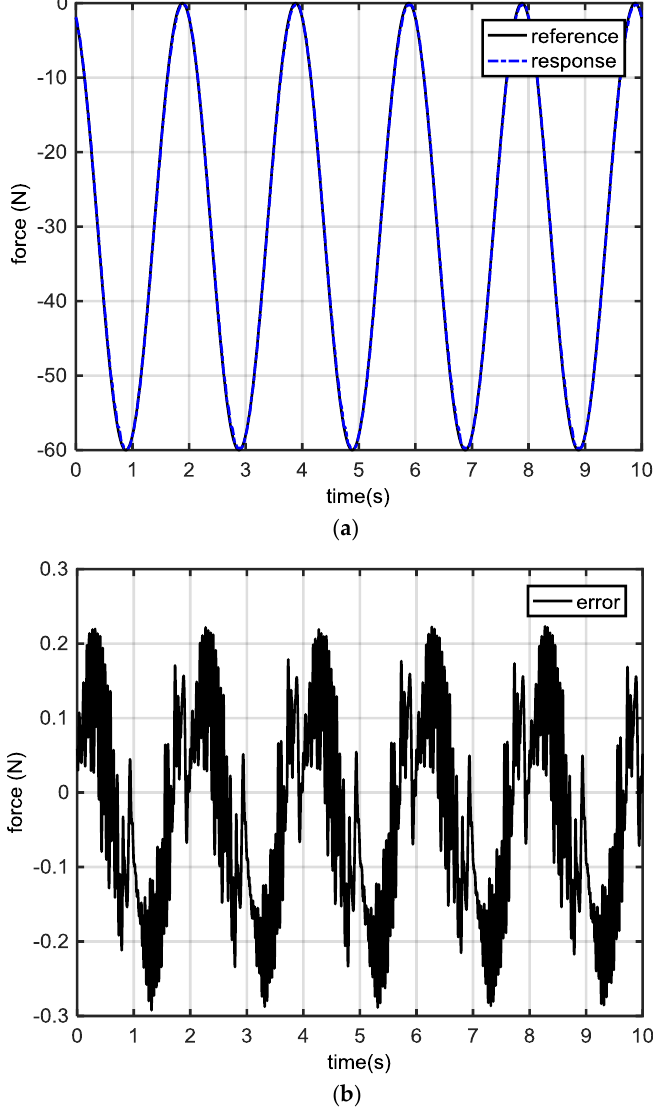
Figure 5. ( a ) Mover response profiles without load ( b ) error response profile.